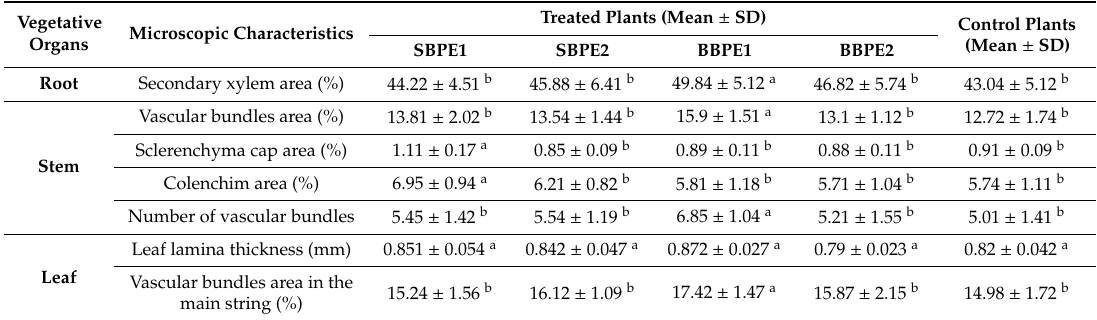
Table 2. The microscopic characteristics of vegetative organs in case of treated and control lemon balm plants.